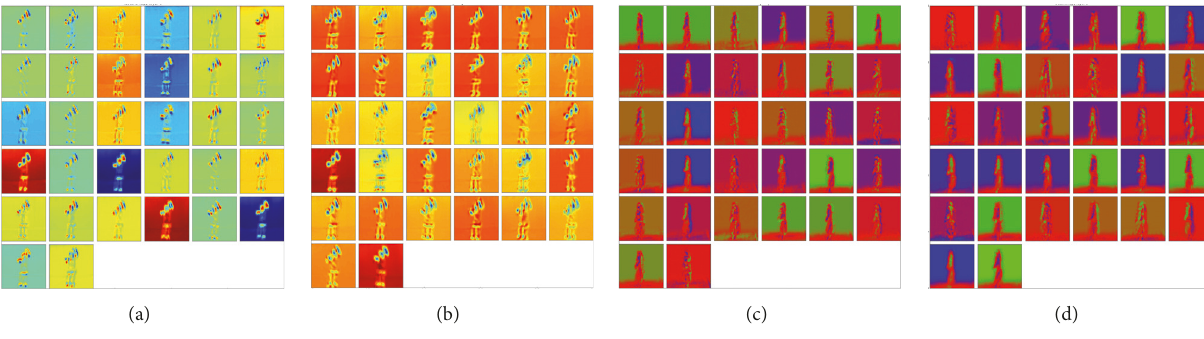
Figure 4: Feature maps. ((a) and (b)) Outputs of convolutional layers 3 and 4, respectively, for offline data. ((c) and (d)) Outputs of convolutional layers 3 and 4, respectively, for online data with 32 filters